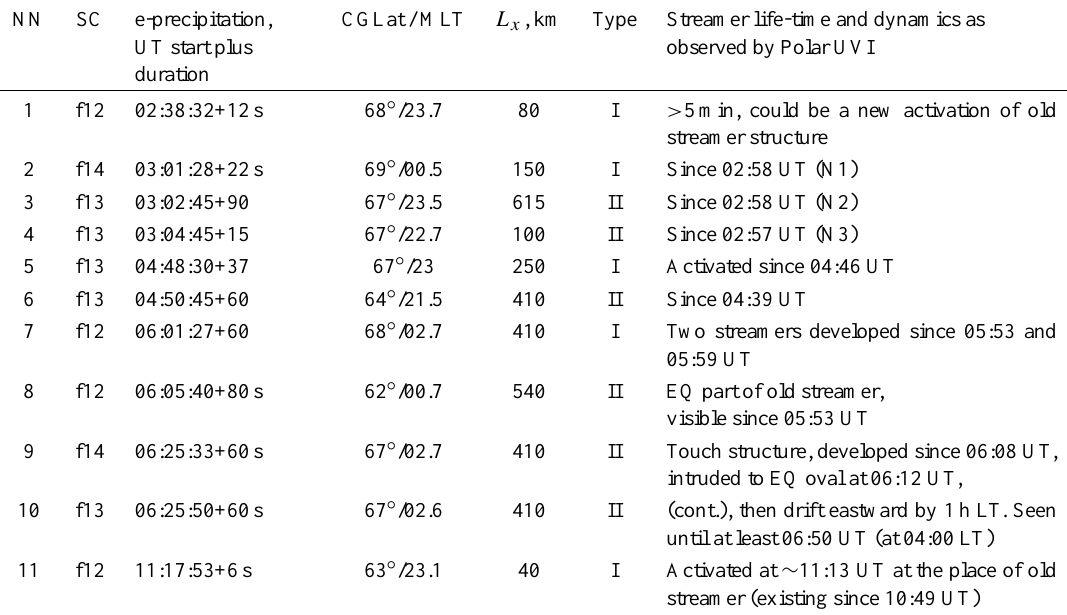
Table 1. Characteristics of auroral streamers and streamer-related precipitation observed during 11 December 1998 SMC event.